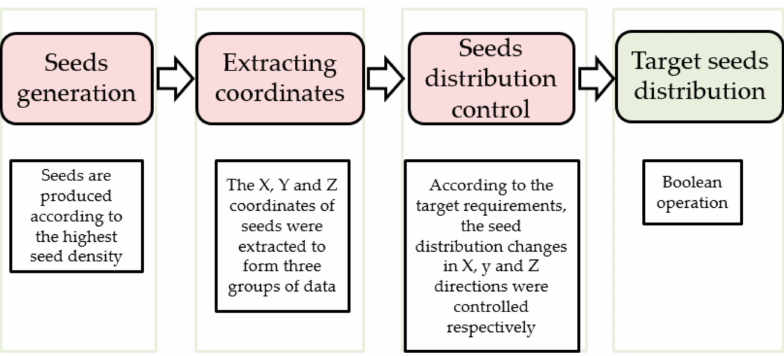
Figure 4. Schematic diagram of method to control points distribution.